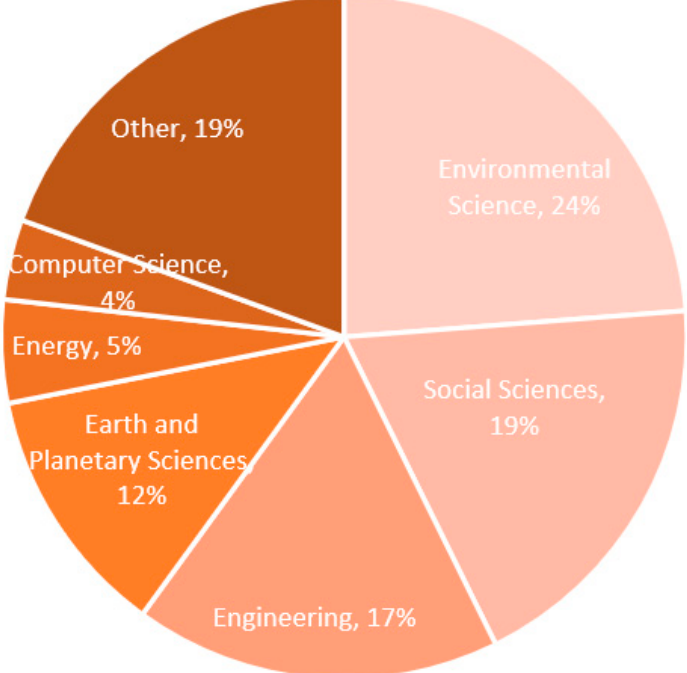
Figure 5. Research distribution along various disciplines.